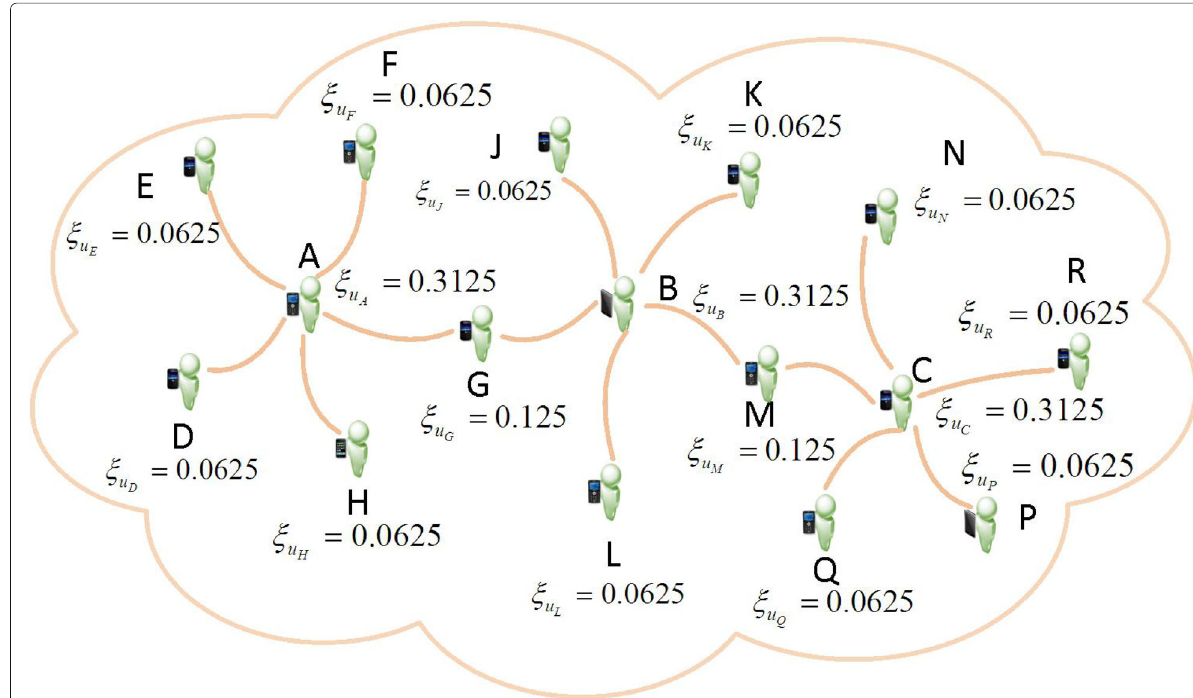
Fig. 3 Logical relationship in community s